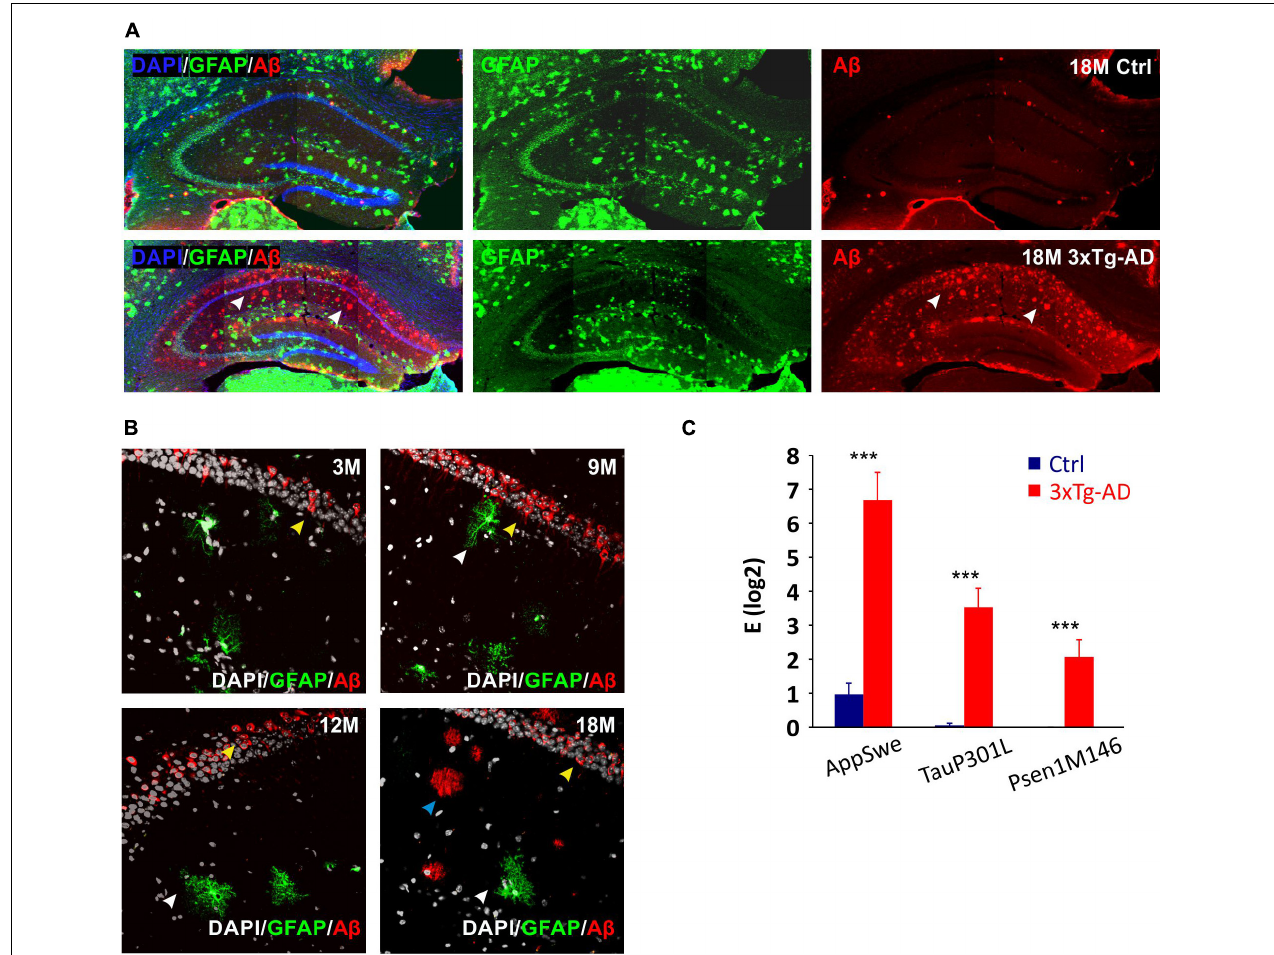
FIGURE 1 | Confirmation of the 3xTg-AD phenotype in hybrids generated by crossbreeding with GFAP/EGFP mice. (A) Overview images of amyloid- β (A β ) expression in hippocampus of 18M-old controls and 3xTg-AD mice. White arrows point to the expression of amyloid plaques in the CA1 region of the hippocampus in a transgenic model of Alzheimer’s disease. (B) Details of A β expression in hippocampal CA1 area of 3-, 9-, 12- and 18M-old mice. Yellow arrows point to the intracellular expression in pyramidal neurons (all ages), blue arrows point to the extracellular plaques (18 months only) and white arrows point to the EGFP labeled astrocytes lacking intracellular A β expression. (C) Relative mRNA expression of 3xTg-AD marker genes in EGFP-positive hippocampal astrocytes isolated from 3M-old mice. The expression of all three mutated genes was maintained in hybrid mice. Data are presented as mean ± SEM. Statistical significance was determined by Student’s t -test. Asterisks indicate significant differences (*** p < 0.001). Ctrl, control; 3xTg-AD, triple transgenic model of AD crossbred with GFAP/EGFP mice; GFAP, glial fibrillary acidic protein; EGFP, enhanced green fluorescent protein; A β , amyloid- β ; AppSwe, Swedish mutation in amyloid precursor protein gene; TauP301L, P301L mutation of tau protein gene; Psen1M146, M146V mutation of presenilin1 gene; 3M, 9M, 12M, 18M, 3-, 9-, 12-, 18-month-old